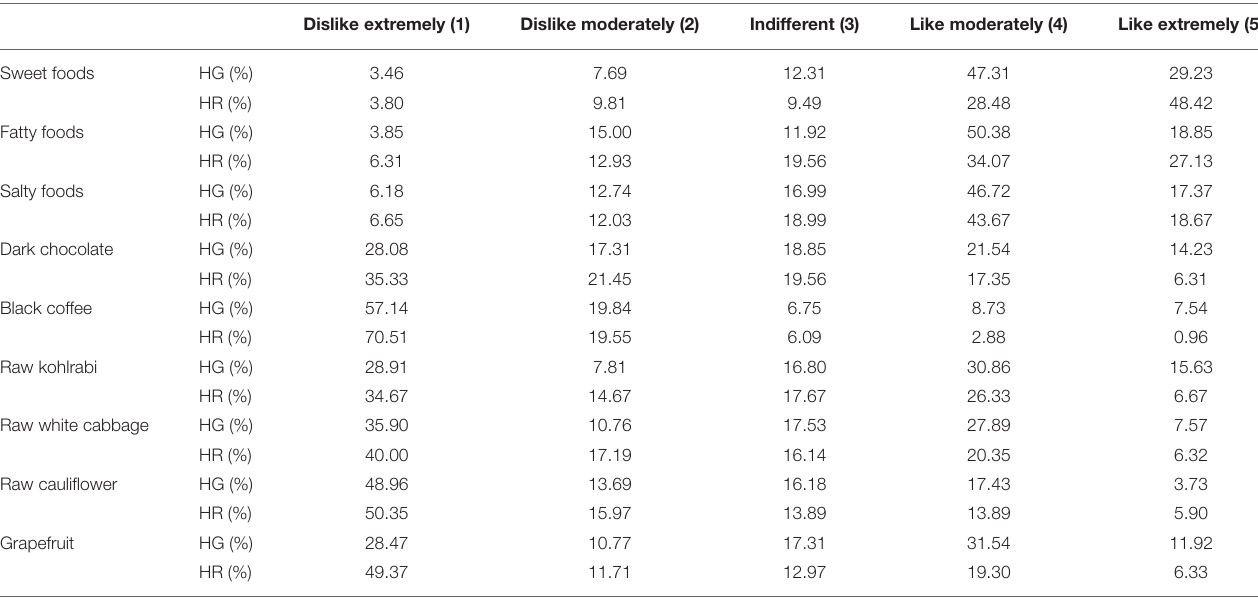
TABLE 5 | Taste preferences of the Hungarian general and Roma populations measured on a five-point Likert scale. Dislike extremely